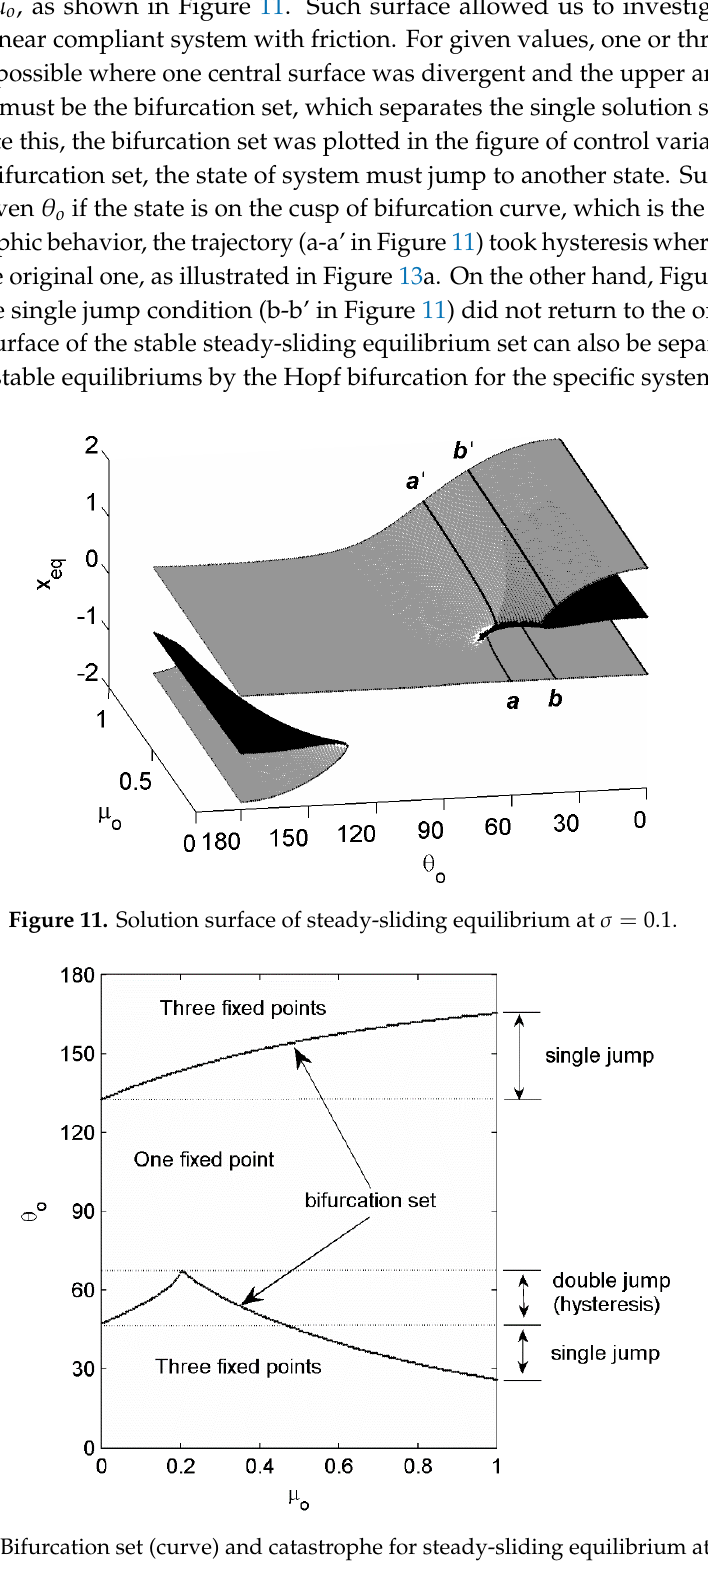
Figure 12. Bifurcation set (curve) and catastrophe for steady-sliding equilibrium at . Figure 13. Trajectories of a-a’ and b-b’ in Figure 10 at ( a ) Figure 13. Trajectories of a-a’ and b-b’ in Figure 10 at ( a )